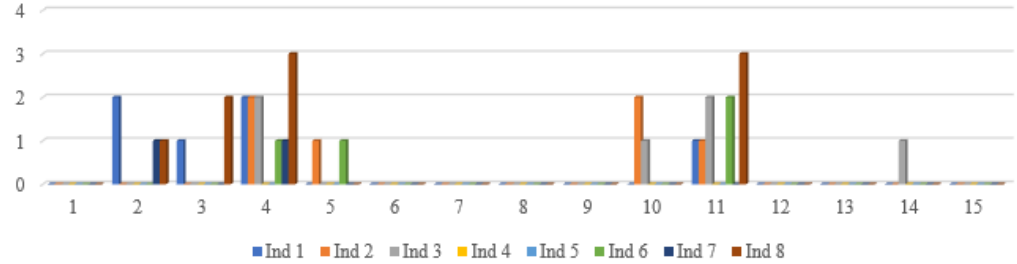
Figure 1. Evaluation of questionnaire comprehension in cognitive interviews. Phase 3 — Translation from Portuguese of Portugal into English. Phase 3—Translation from Portuguese of Portugal into